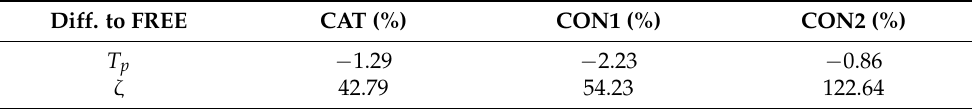
Figure 13. Comparative time histories of motions for decay tests in pitch. Table 9. Comparative changes of each system’s natural period, T p , and of each system’s percentages of critical damping, ζ , caused by the presence of the mooring systems, obtained from decay tests in